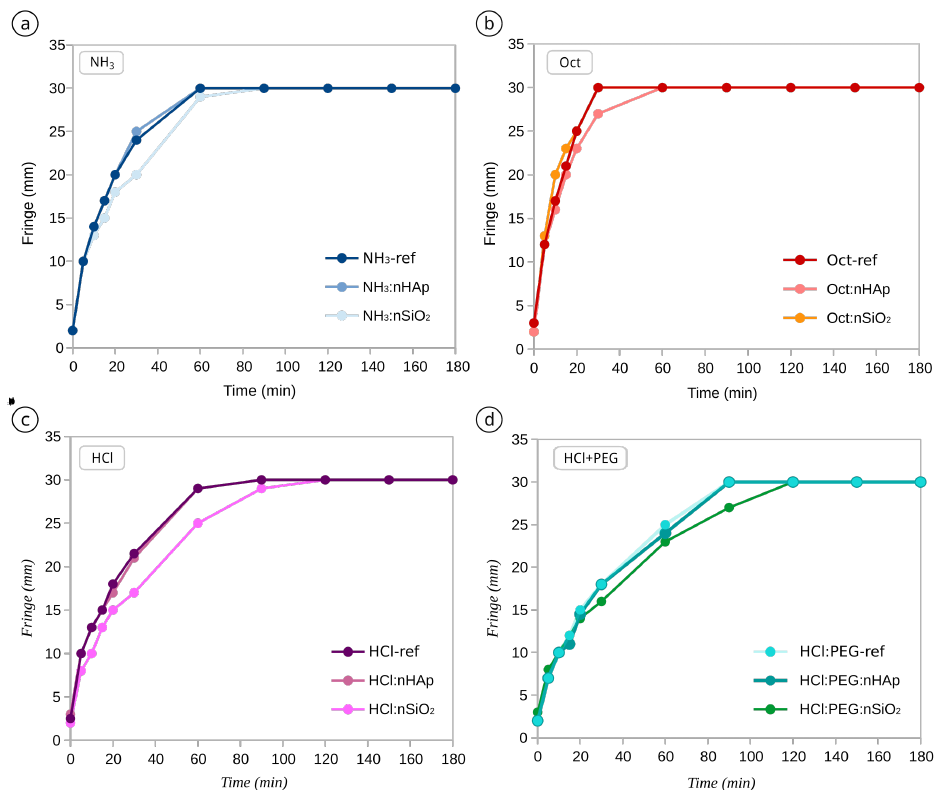
Figure A3. Capillary suction fringe evolution upon treatment with all the formulations under